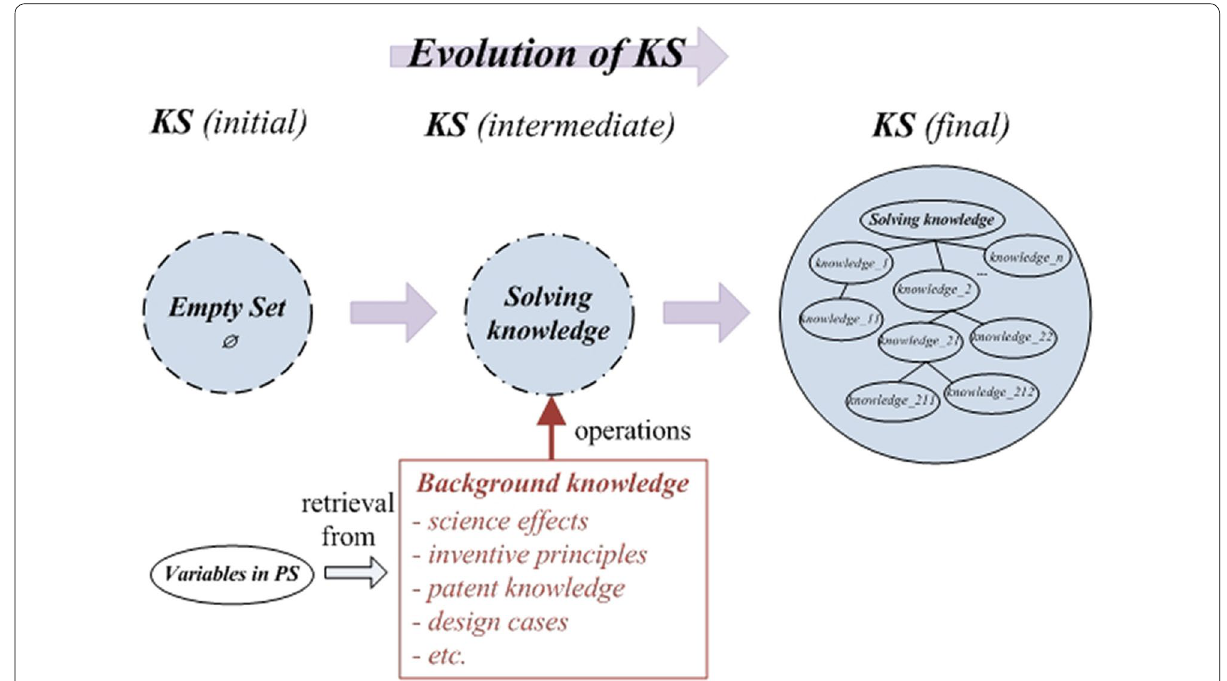
Figure 7 Evolution of the knowledge space